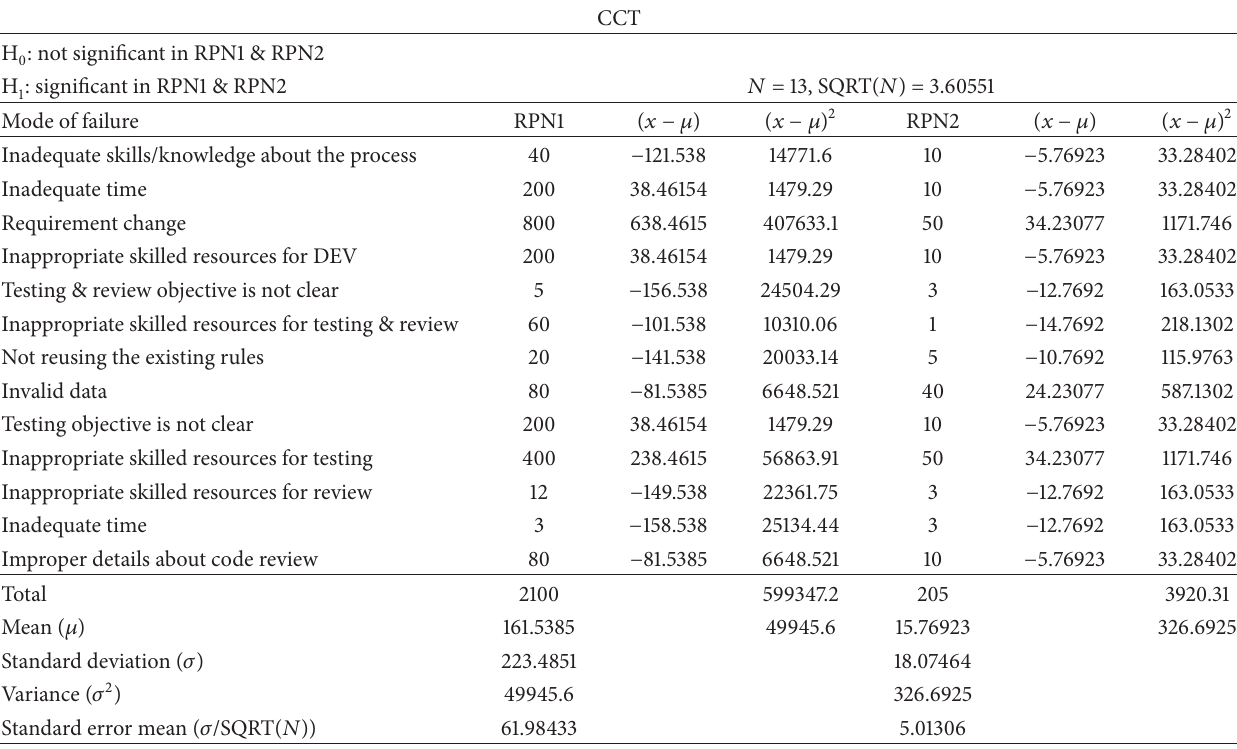
Table 5: SWFMEA validation report (RPN1 TO RPN2).